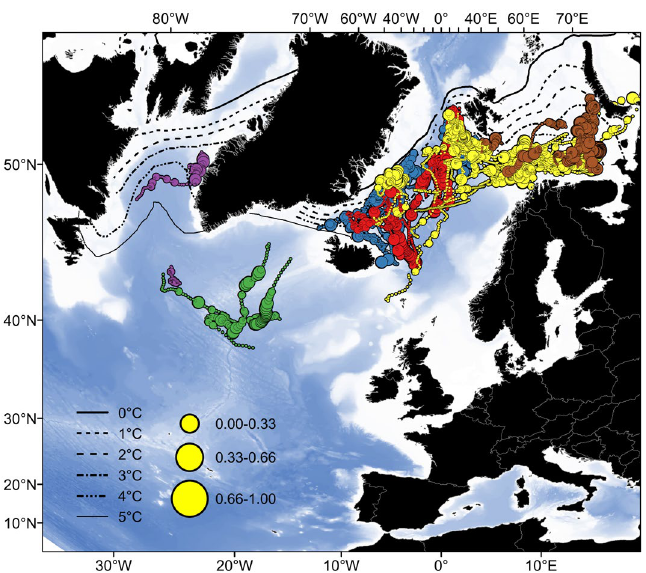
Figure 3. Post-migration diving behavior of Atlantic salmon in relation to the polar front (as bounded by the 0 °C and 5 °C annual mean temperature isolines). Post-migration is defined as > 11 weeks after release. Symbol size reflects the proportion of time spent at depths greater than 10 m. Color coding of salmon populations is the same as for Fig. 1A. Salmon released from Iceland and Spain provided data only from few fish and for a limited period, so data from these taggings are not included in the figure. Sea surface temperature contours were derived from mean monthly SST data 156 (NOAA_ERSST_V4) for the period of the study (January 2008 to December 2013). Data were provided by the NOAA/OAR/ESRL PSL, Boulder, Colorado, USA, from their Web site at 158 https:// www1. ncdc. noaa. gov/ pub/ data/ cmb/ ersst/ v4/ netcdf/. Maps were drawn using ESRI ArcGIS Desktop v10.5.